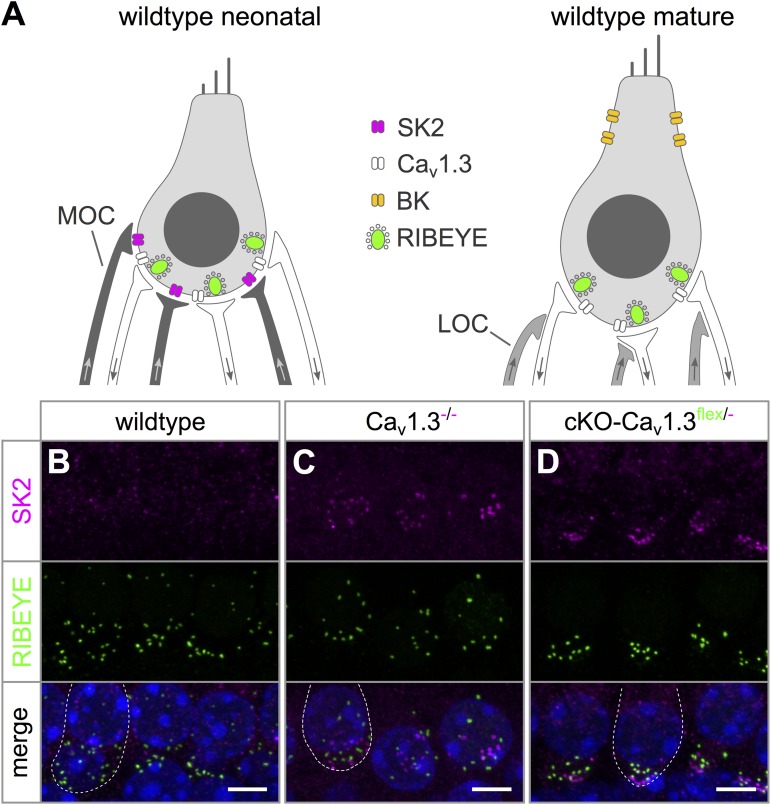
Persistence of SK2 channels in IHCs of cKO-Cav1.3flex/- mice. (A) Sketch of a wildtype IHC before (left, neonatal) and after the onset of hearing (right, mature) depicting differences in shape, ion channel composition and innervation. Immature IHCs express SK2 channels (magenta) at the basal pole, which are down-regulated after the onset of hearing, and do not possess BK channels. At the onset of hearing, BK channels are up-regulated and localize mainly to the neck of mature IHCs. Medial olivocochlear (MOC) efferent fibers of the SOC (dark gray) innervate IHCs of neonatal mice. Whereas mature IHCs lack direct efferent innervation, their afferent fibers receive lateral olivocochlear (LOC) efferent fibers (light gray). (B) SK2 labeling (top, magenta) was absent from apical-turn wildtype IHCs at 4–6 weeks of age. (C,D) Dot-like SK2 labeling was present at the basal pole, but not co-localized with synaptic ribbons (RIBEYE, middle, green) of apical-turn IHCs of a Cav1.3-/-(C) and a cKO-Cav1.3flex/- mouse at the age of 4–6 weeks. The merged image is shown with nuclei stained in blue with DAPI. Scale bars: 5 μm.